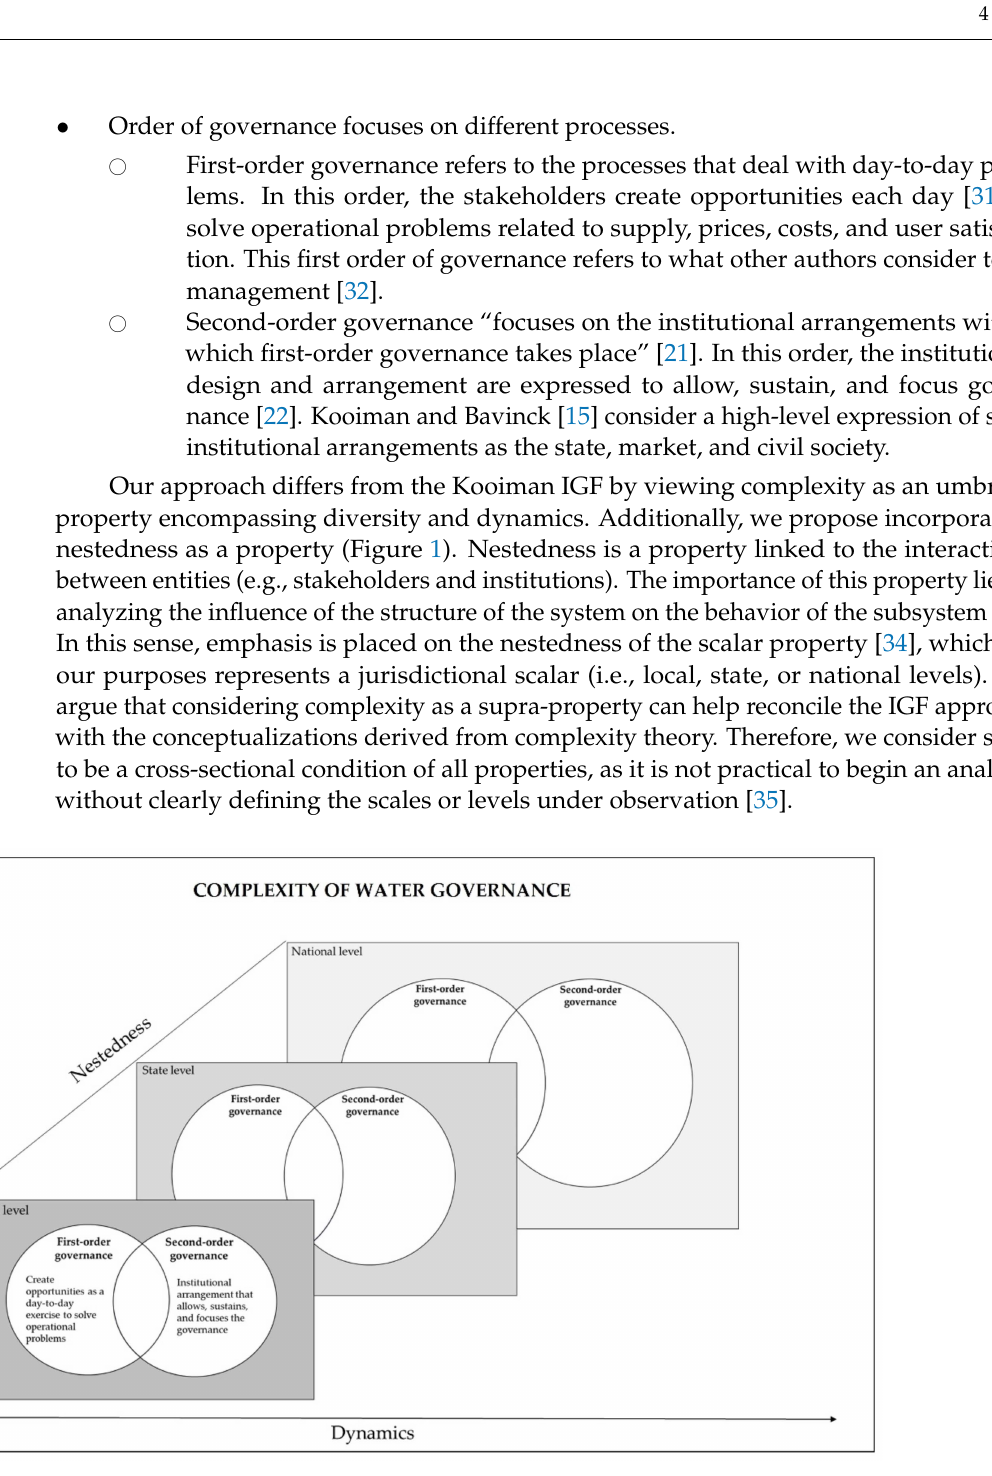
Figure 1. The Water Governance Complexity Framework proposes the analysis of diversity, nestedness, and dynamics properties in at least three levels in jurisdictional (i.e., local, state, and national) and temporal (levels are defined a posteriori according to periods of institutional change) scales in the first and second orders of governance. Source: Adapted from Kooiman and Bavinck